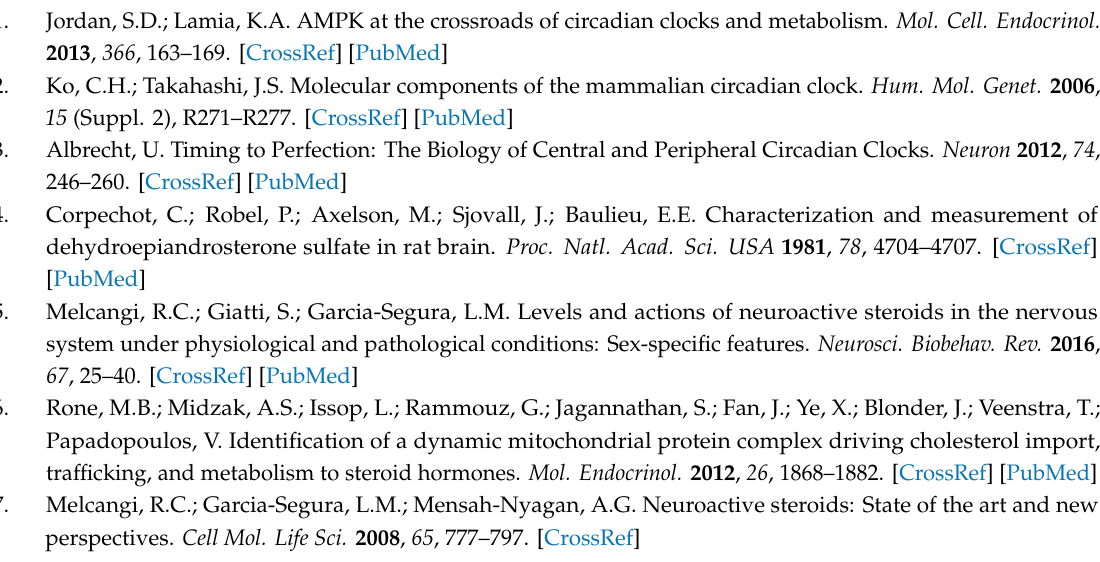
Supplementary Figure S1, Supplementary Figure S2, Supplementary Table S1: Summary of the analysis of circadian rhythmicity using the JTK_Cycle and One-way ANOVA; Supplementary Materials and Methods S1 (related to Supplementary